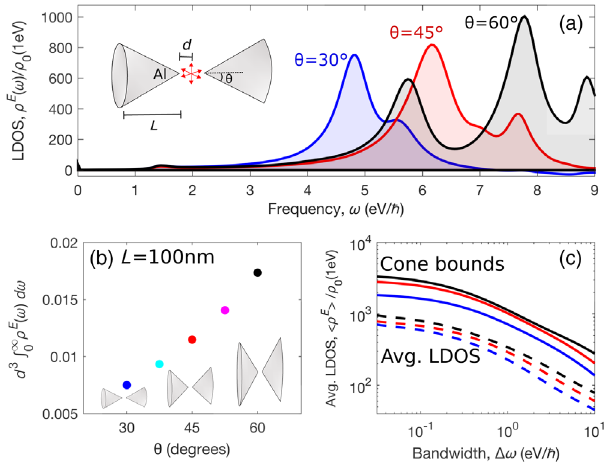
FIG. 3. (a) Electric LDOS for a double cone made of Al with d ¼ 10 nm ( L ¼ 15 , 25, 35 nm for θ ¼ 30 °, 45°, 60°, respec- tively). (b) As the opening angle increases, the all-frequency integrated electric LDOS increases in confirmation of the monotonicity theorem. (c) Average electric LDOS centered at their peaks ( ω 0 ¼ 4 . 8 , 6.2, 7 . 8 eV = ℏ for θ ¼ 30 °, 45°, 60°, respectively) for each angle are shown along with their respective bounds. The double cones approach, within almost a factor of 2, their upper bounds, over a large range of